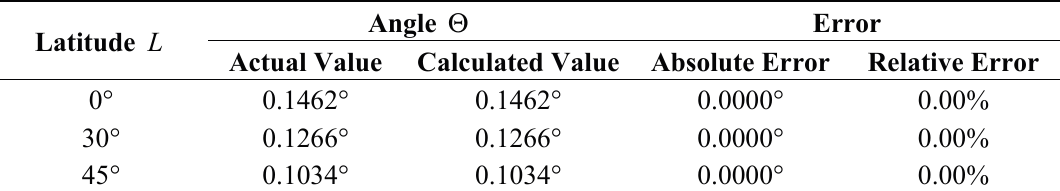
Table 4. The difference between calculated Θ and actual Θ